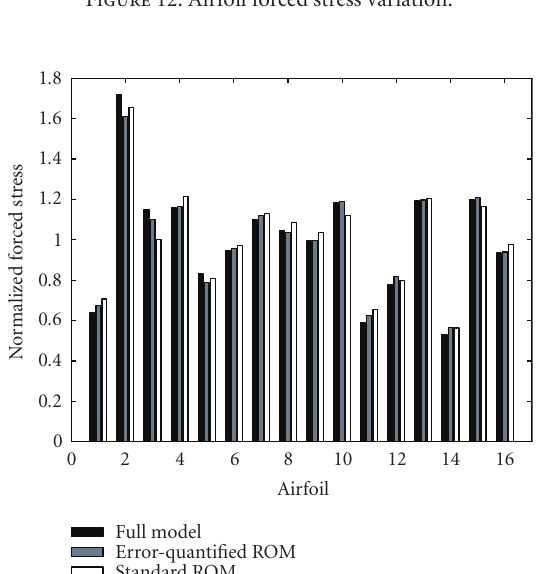
Figure 12: Airfoil forced stress variation.